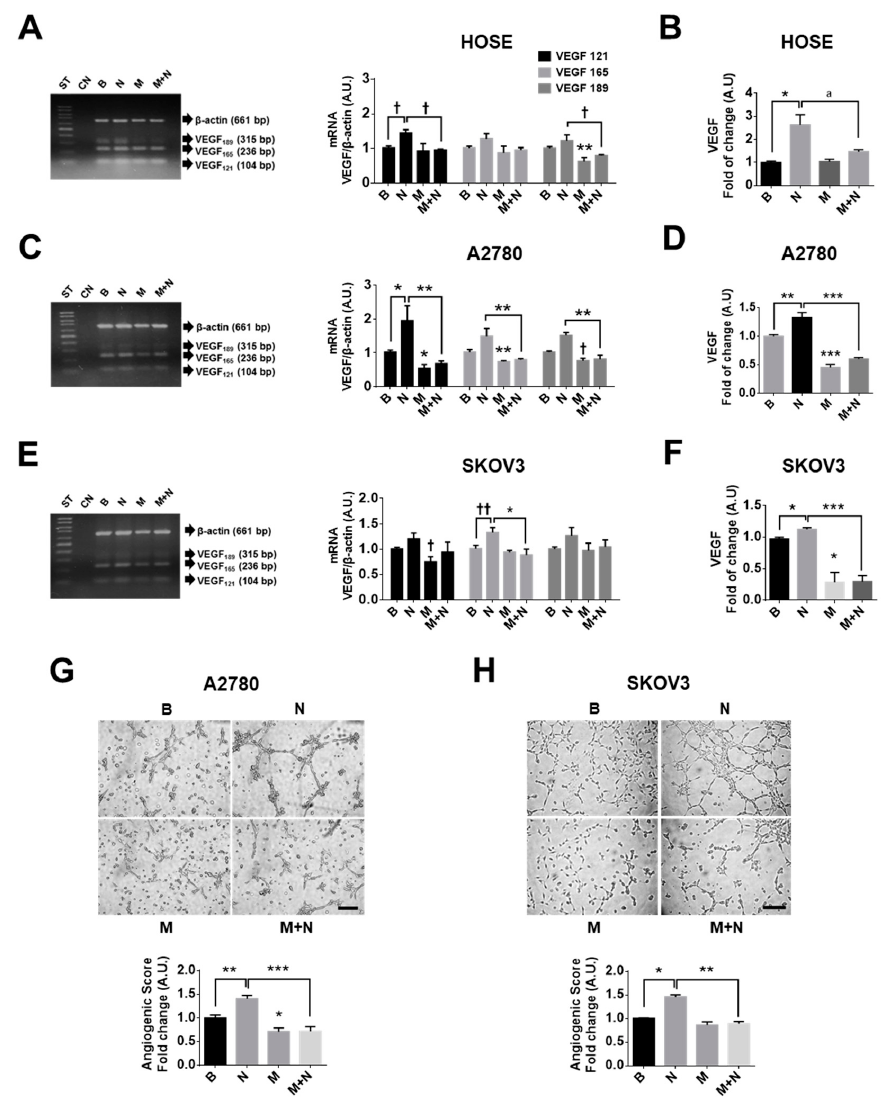
Figure 4. Metformin prevents the NGF induced VEGF expression and angiogenic properties of ovarian cells. Ovarian cells were treated with metformin 10 mM for 48 h and/or NGF 100 ng/mL or 150 ng/mL (A2780/HOSE cells and SKOV3 cells, respectively) for 24 h or the last 2 h, and then processed to detect VEGF expression. ( A , C , E ) Representative agarose gels with PCR products of different VEGF transcripts (VEGF 121, VEGF 165 and VEGF 189 amino acids) in ovarian cells. Semi-quantification of N = 4 or more independent experiments. ( B , D , F ) VEGF detection in the culture supernatants of ovarian cells by enzyme-linked immunosorbent assay (ELISA). N = 4 or more independent experiments induplicate. ( G , H ) Angiogenic score calculated as indicated in the methodology section with conditioned medium from A2780 or SKOV3 cells, respectively. Bar = 50 µ m. N = 4 or more independent experiments (4–8 images were evaluated per experiment). * p < 0.05; ** p < 0.01 and *** p < 0.001 as indicated or with respect to basal conditions. Statistical analysis: Kruskal–Wallis and Dunn´s post-test. † p < 0.05 and †† p < 0.01 with respect to basal conditions or as indicated using